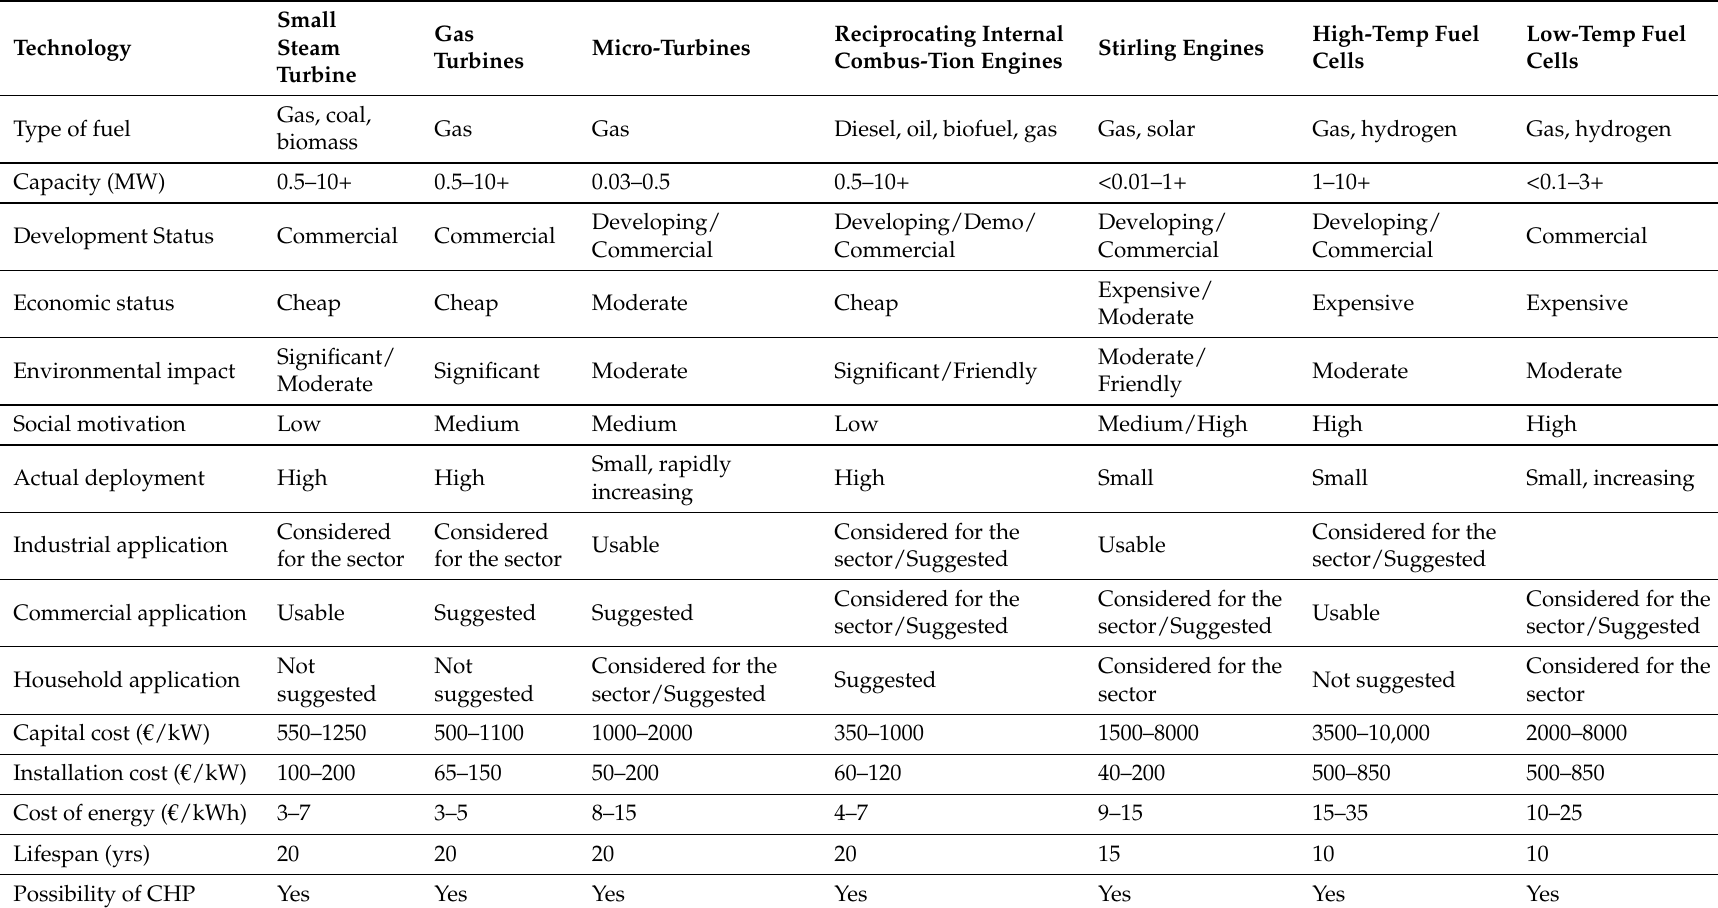
Table 2. Summary of conventional energy-based microgrid technologies